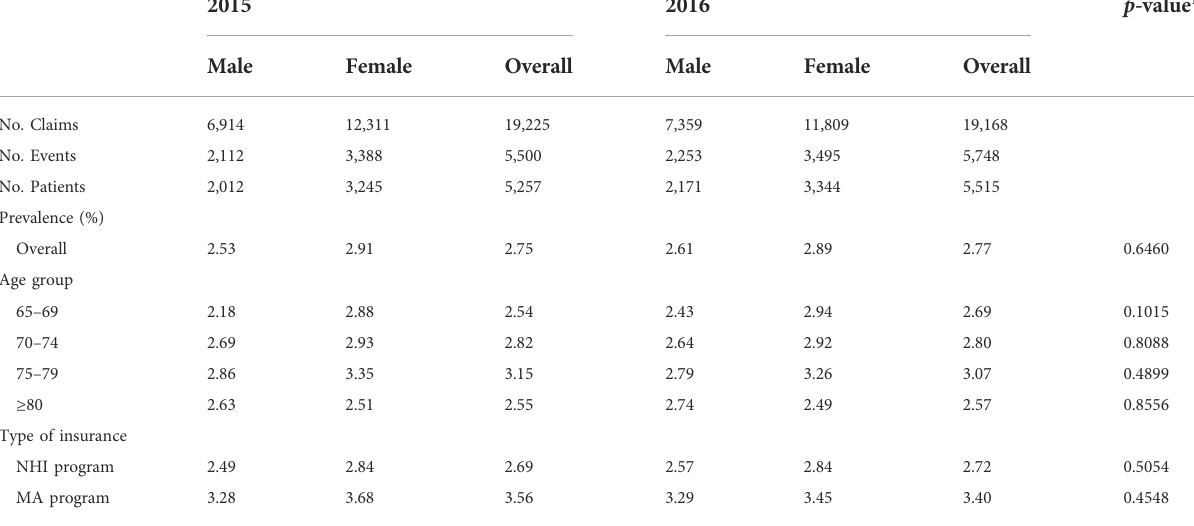
TABLE 2 Prevalence of adverse drug events by sex, age group, and type of insurance.